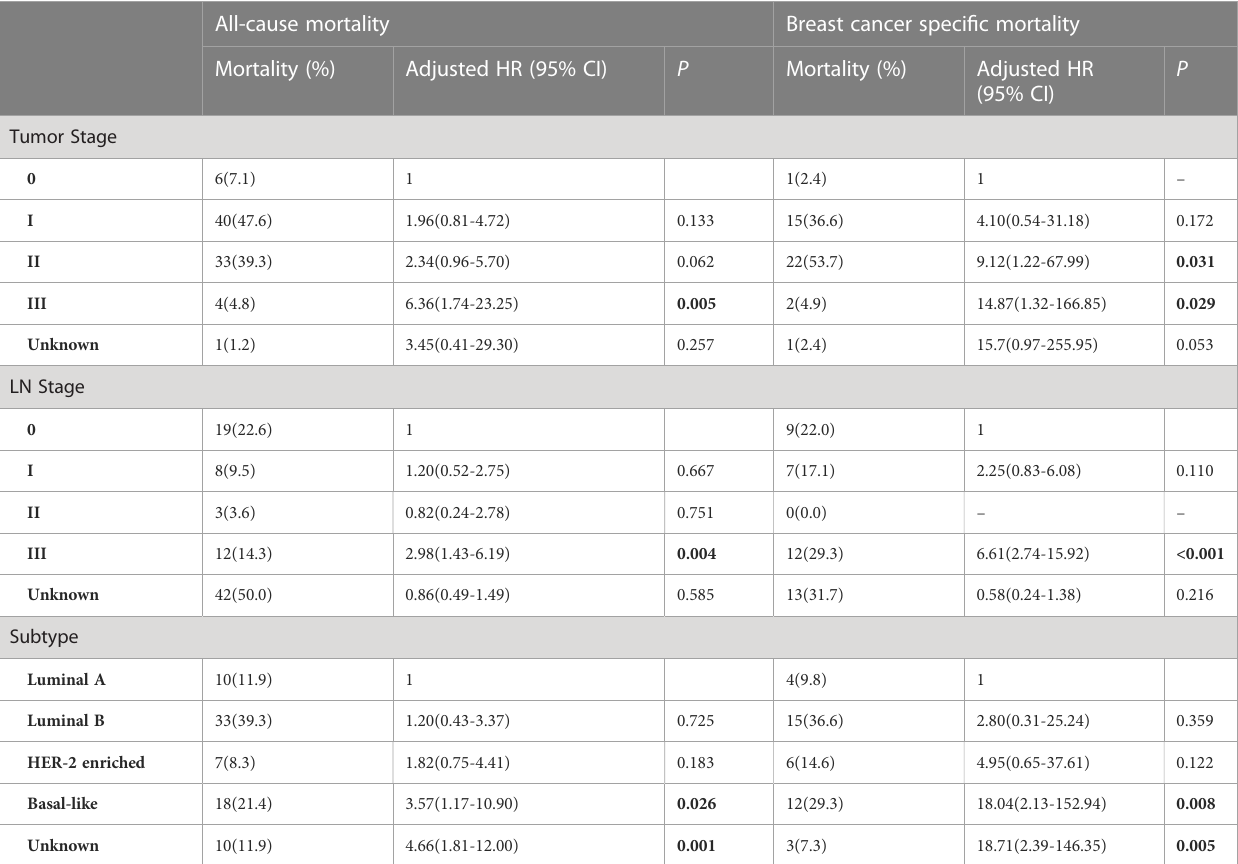
TABLE 3 Adjusted HRs for all-cause mortality and BCSM according to tumour stage, LN stage, and subtype.